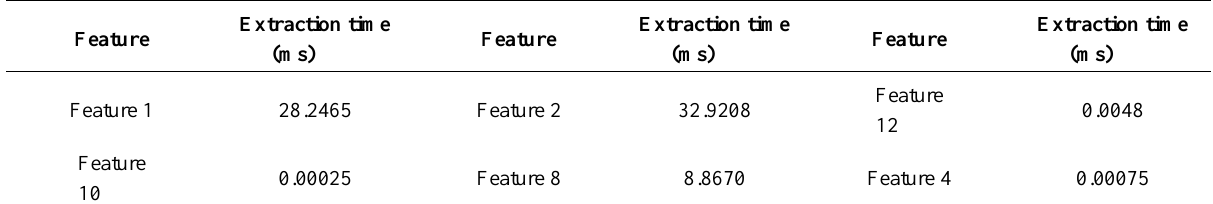
Table 1. The cost of some features.